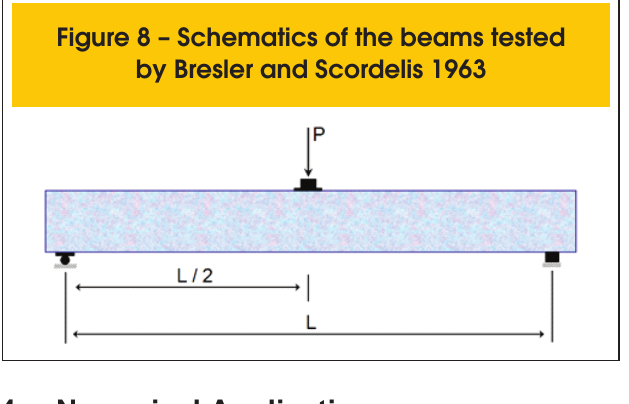
Figure 9 – Discretization and